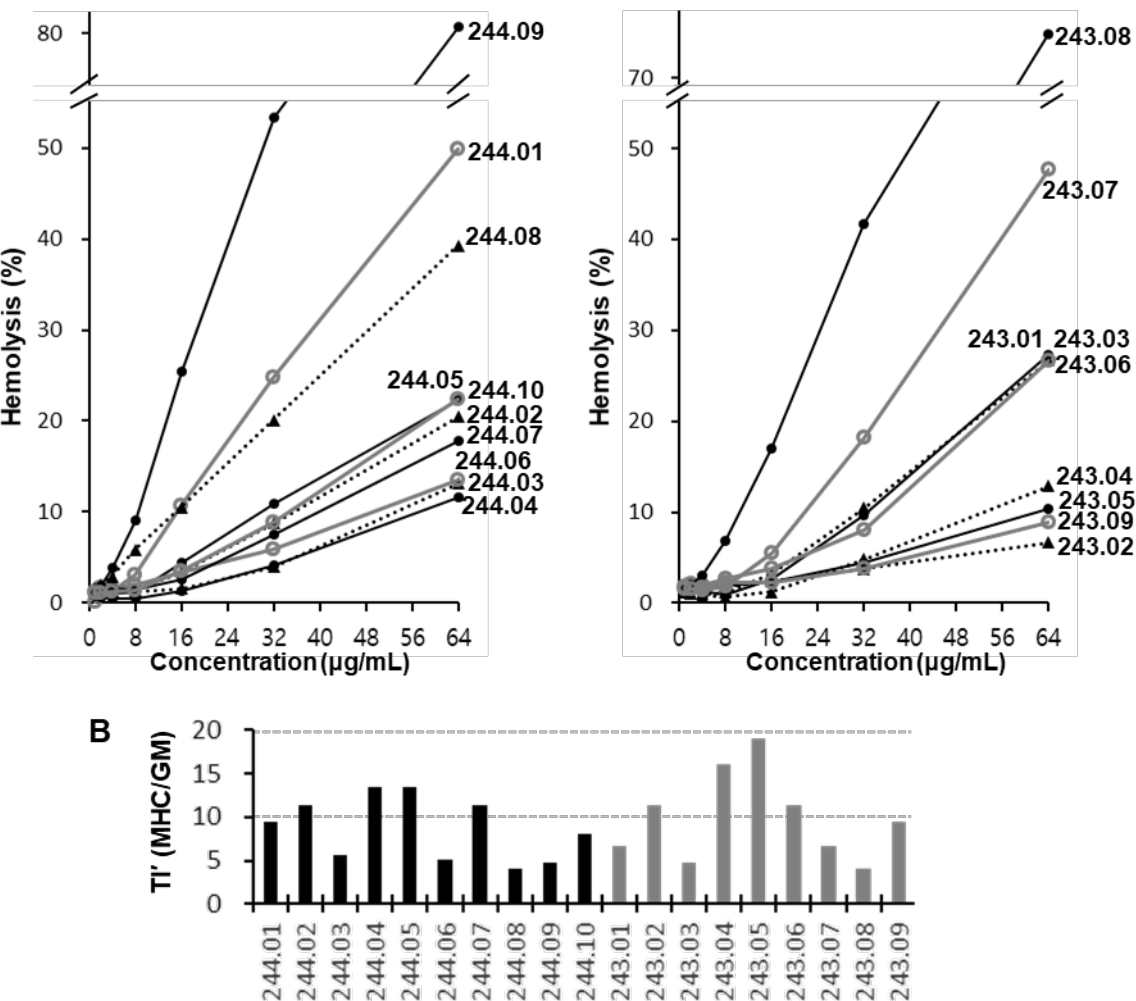
Figure 2. Hemolytic activity of WALK peptides. ( A ) Percentage hemolysis of human red blood cells treated with the serially diluted WALK244 and WALK243 peptides. ( B ) Pseudo-therapeutic index (TI ’ ) of WALK peptides deduced from minimal hemolytic concentration (MHC) and antibacterial GM (geometric mean of minimal inhibitory concentrations) values.